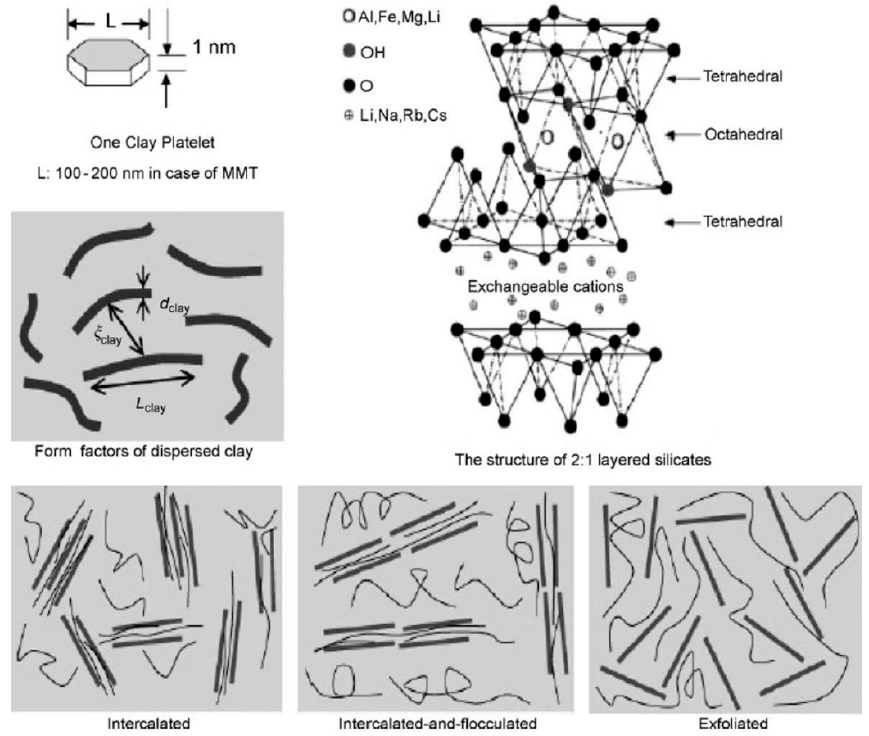
Figure 5. Schematic diagram showing the structure of 2:1 phyllosilicate and the polymer clay nanocomposites [13].